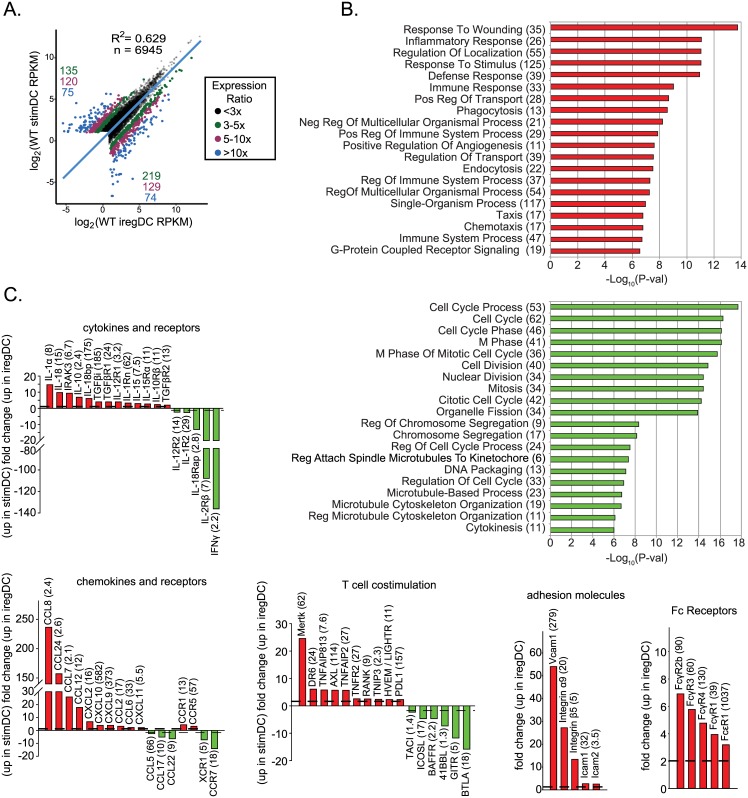
iregDCs have a distinct expression profile compared to stimDCs.StimDCs and iregDCs were obtained from day 9 LCMV-Cl13 infected mouse splenocytes, RNA was harvested and subjected to RNA-seq. A. Graph scatter shows the log-transformed expression values for genes expressed at 2 RPKM or more in at least one sample. Dots are color-coded based on the ratio of RPKM values to indicate differentially expressed (DE) genes between the two cell types. The number of genes in each DE group are indicated in the top left (higher in stimDCs) and bottom right (higher in iregDCs) corners. Selected DE genes from this dataset are shown in the rest of the panels to highlight important gene groups as indicated on top of each panel. B. Gene Ontology (GO) term over representation analysis was performed on a set of genes that were at least 5-fold differentially expressed between the iregDC and stimDC samples. Plots show the statistical significance of GO terms that are enriched in genes expressed at higher levels in iregDCs and stimDCs. The number of genes that were classified under a particular GO term are indicated in brackets. GO terms with an adjusted (Benjamini-Hochberg method) p-value of < = 0.05 were considered to be enriched in the DE gene set. C. Bar graphs show the fold change in the indicated gene. Up on the y-axis indicates increase in iregDC (red). Down on the y-axis indicates increase in stimDC (green). The number in parenthesis indicates the RPKM value of the highest sample (to indicate relative expression level).